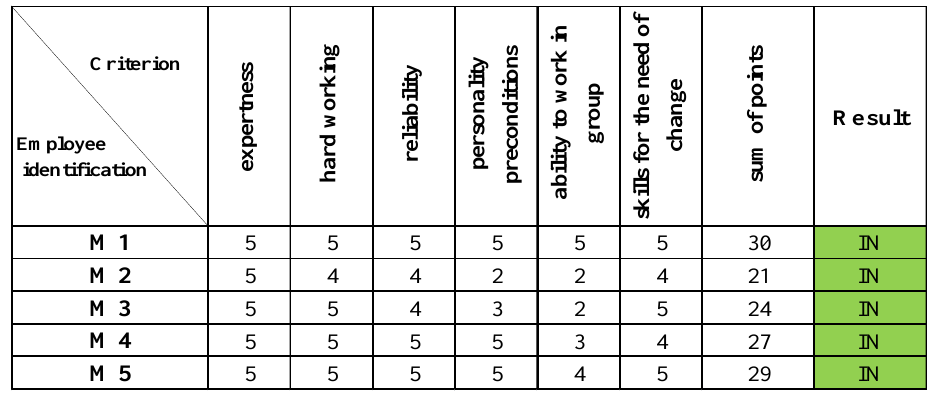
Table 1 – Evaluation of criteria of relationship by director - manager LC SA a.